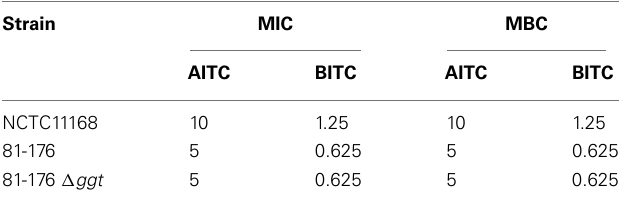
Table 3 | Minimal inhibitory (MIC) or bactericidal (MBC) concentrations in broth